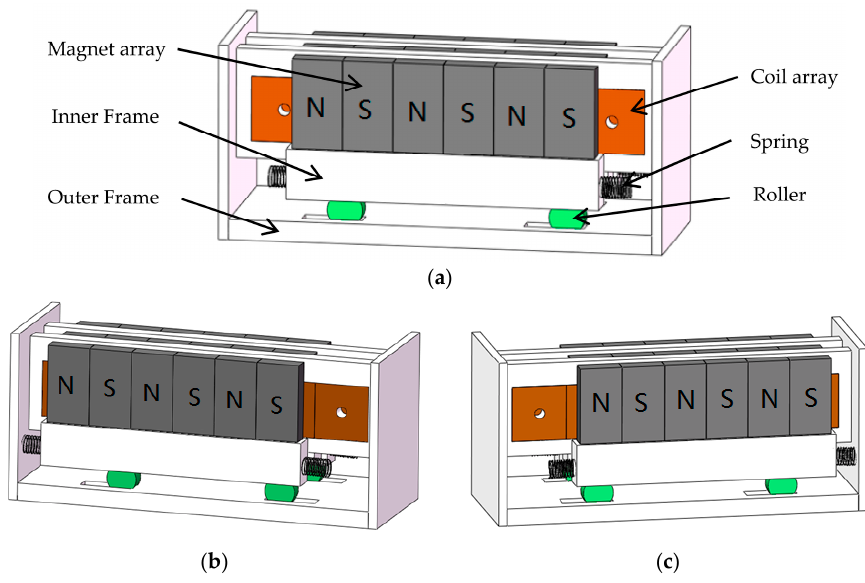
Figure 1. Schematic of an impact-based electromagnetic kinetic energy harvester: ( a ) freely movable; ( b ) left springs being compressed; and ( c ) right springs being compressed.